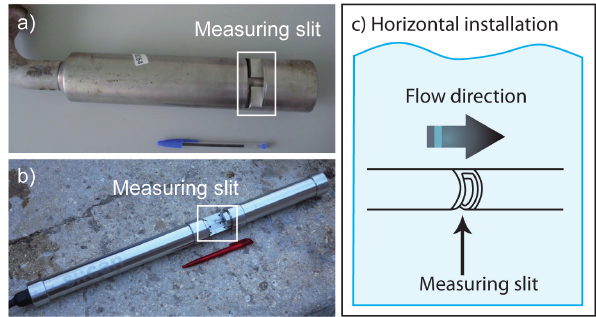
Figure 1. UV/VIS sensors: (a) double wavelength spectrophotome- ter (DWS) with measuring path of 5mm; (b) multiple wavelength spectrophotometer (MWS) with measuring path of 35mm; (c) prin- ciple of horizontal installation of the